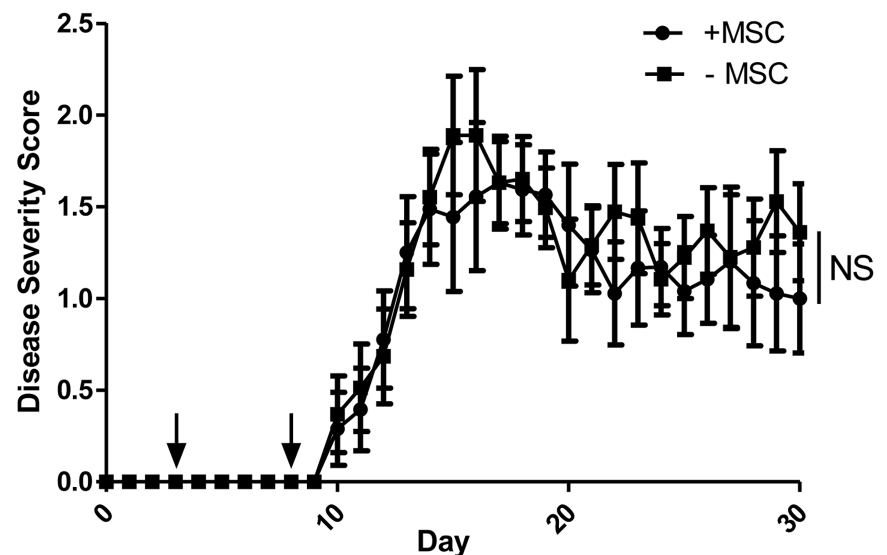
Fig 1. MSCs do not affect the MOG 35 – 55 EAE disease course. C57BL/6 mice were immunized with MOG 35 – 55 in complete Freund ’ s adjuvant. At days 3 and 8 post-induction (black arrows), mice were administered either murine MSCs or phosphate-buffered saline vehicle. Mice were scored daily in a blinded fashion. Data shown are a combination of two independent experiments. Statistical analysis was done with the Mann-Whitney U